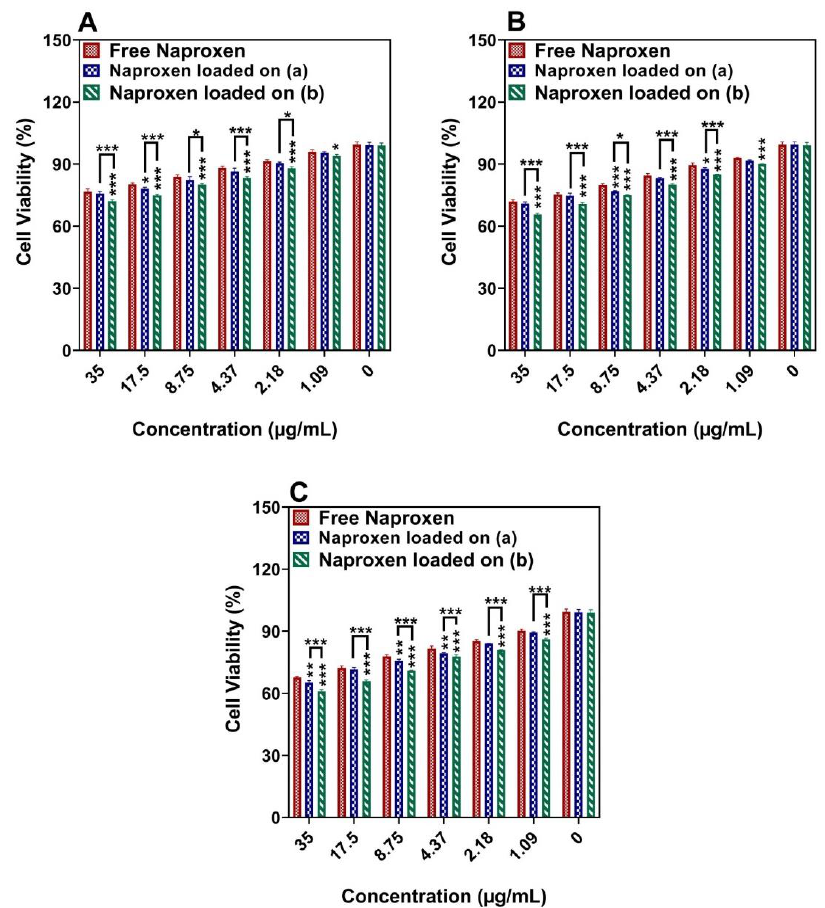
Figure 8. The effect of free drug and drug-loaded carriers (a) Ni 1−x Co x Fe 2 O 4 @Methionine NPs and (b) Ni 1−x Co x Fe 2 O 4 @Methionine@PEG NPs on the viability of MDA-MB-231 cells after incubation for ( A ) 24 h, ( B ) 48 h, and ( C ) 72 h. Data are expressed as mean ± SD ( n = 5) (*** p < 0.001, ** p < 0.01, * p <